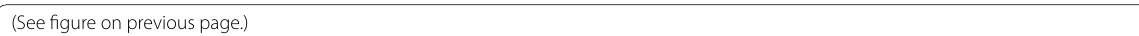
figure on previous Fig. 6 The regulatory network of LINC00242/ miR-1-3p/ G6PD axis. a Six lncRNAs (LINC00707, MALAT1, NEAT1, SNHG14, UCA1 and LINC00242) targeted miR-1-3p was screened according LncBase Predicted v.2 database and ENCORI database. b RT-PCR assay was performed to detect the expression level of these six lncRNAs in gastric cancer tissues and paracancerous tissues. N 77; ** P < 0.01 compared to adjacent tissues. c = LINC00242 expression level in gastric cancer cell lines (AGS and MGC-803) and gastric epithelial cell line (GES-1) was detected. N 3; * P < 0.01 = compared to GES-1 cell. d Kaplan–Meier survival analysis confirmed that the low expression of LINC00242 was related to the better prognosis of gastric cancer patients (log-rank test, P < 0.05). e Target relationship between LINC00242 and miR-1-3p was predicted by bioinformatics analysis (left) and validated by dual-luciferase reporter assay (right). N 3; ** P < 0.01 compared to mimics NC group; ## P < 0.01 compared to inhibitor NC = group. f The linear analysis revealed a negative correlation between LINC00242 and miR-1-3p expression in gastric cancer tissues (N 77). g The = linear analysis revealed a positive correlation between LINC00242 and G6PD expression in gastric cancer tissues (N 77). h The effect of knockdown = of LINC00242 on miR-1-3p expression in AGS and MGC-803 cells was verified by qRT-PCR. N 3; ** P < 0.01 compared to sh-NC group. i , j The effect = of silencing of LINC00242 on G6PD mRNA and protein expression in AGS and MGC-803 cells was verified by qRT-PCR and western blot assay. N 3; = ** P < 0.01 compared to sh-NC